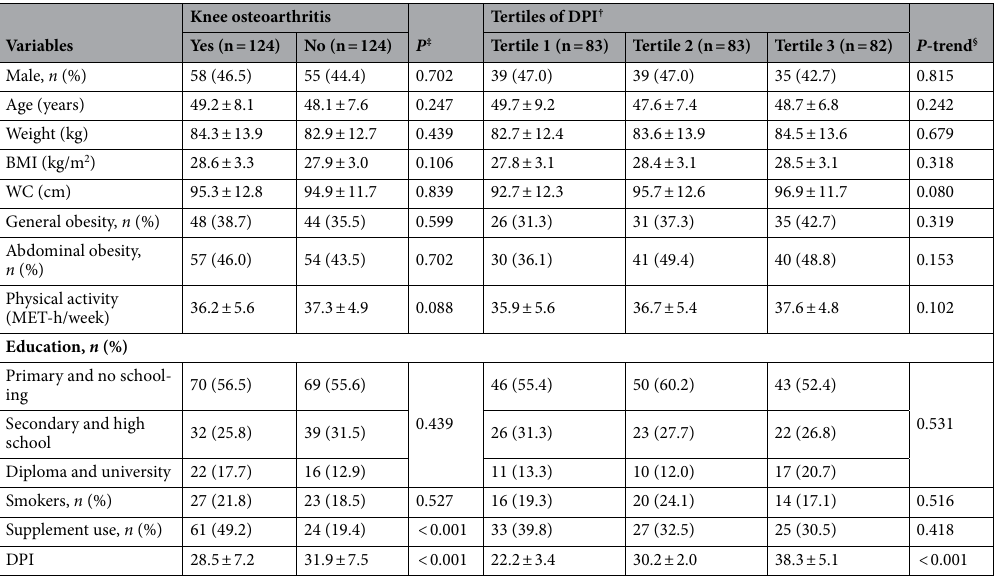
Table 1. Characteristics of patients with knee osteoarthritis, controls and all the participants across tertiles of dietary phytochemical index (DPI). Data are expressed as mean ± standard deviation unless indicated otherwise. Min and Max of DPI in the participants were 12.2 and 62.1, respectively. DPI dietary phytochemical index, BMI body mass index, WC waist circumference. † Tertile cut-points of DPI are as follows: first tertile, < 26.80; second tertile, 26.80 to 33.15; third tertile, > 33.15. ‡ Obtained from independent samples t -test or χ 2 test for continuous or categorical variables, respectively. § Obtained from ANOVA or Mantel-Hanszel extension test for continuous or categorical variables,